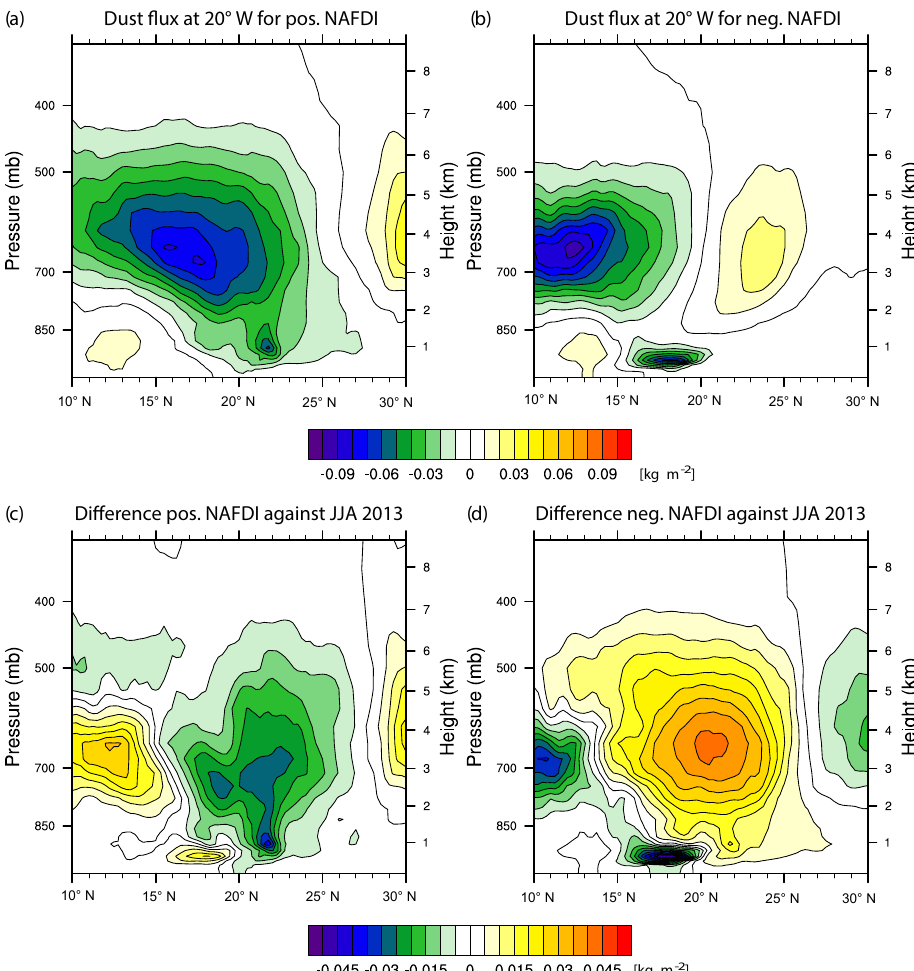
Figure 8. Composite plots of the vertically integrated zonal dust flux (kgm − 2 ) at 20 ◦ W for the days of June, July, August 2013, which correspond to the 75th percentile (a) and 25th percentile (b) of NAFDI index values. Dust export towards the North Atlantic is represented by negative values; positive values indicate transport back to the northern African continent. Dust fluxes are totals over the 10–25 ◦ N latitudinal band. Differences in dust flux compared against the JJA 2013 mean dust flux are shown in (c) and (d)